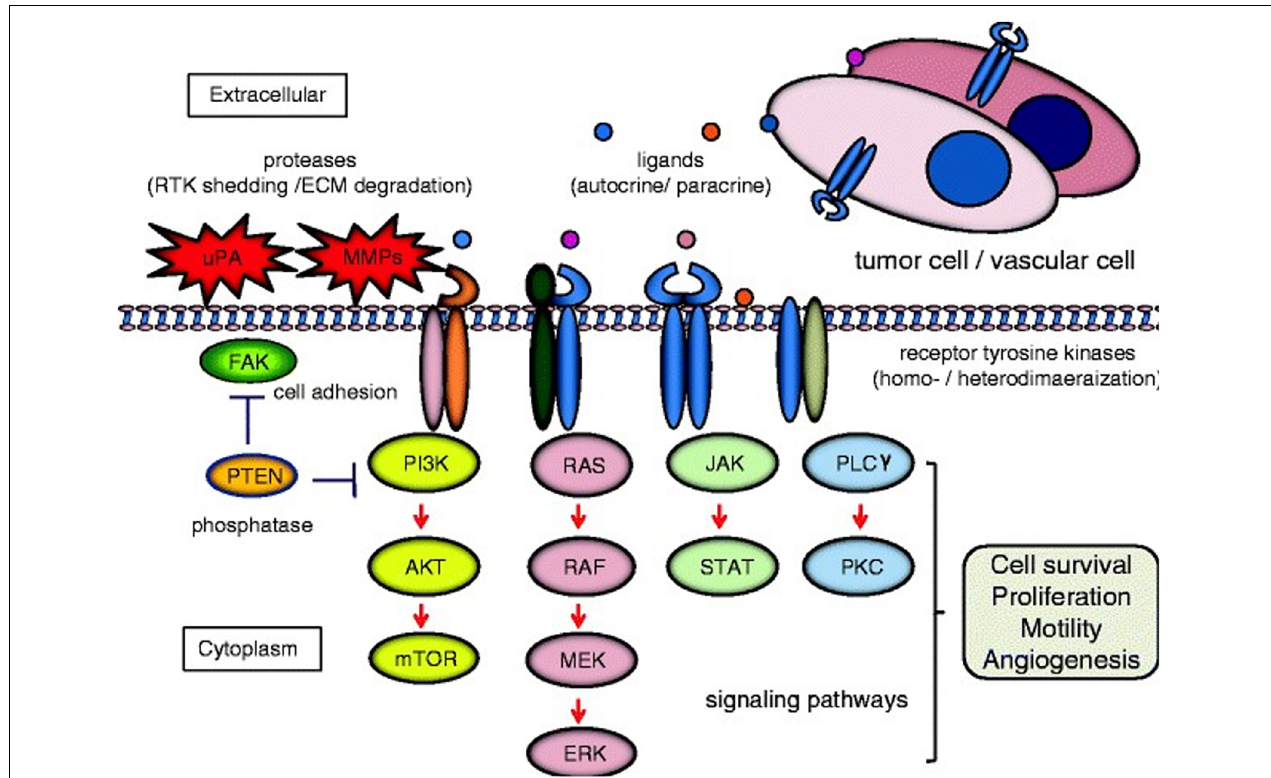
FIGURE 2 | Cell signaling pathways induced by receptor tyrosine kinases (RTK). Homo-/heterodimerization of RTKs are caused by their ligands in autocrine or paracrine fashion. The dimerized receptors can initiate signal transduction cascades involved in cell survival, proliferation, motility, and angiogenesis e.g., phosphatidylinositol 3-kinase (PI3K)/AKT/mTOR; RAS/RAF/mitogen-activated protein kinase (MEK)/extracellular signal-regulated kinase (ERK); Janus kinase (JAK)/signal transducer and activator of transcription (STAT); and phospholipase C γ (PLC) γ /protein kinase C (PKC). Examples of cross-talk between RTK signaling and proteins associated with cell invasion [e.g., urokinase-type plasminogen activator (uPA), matrix metalloproteinase (MMP)s, focal adhesion kinase (FAK), and phosphatase and tensin homolog deleted from chromosome 10 (PTEN)] are demonstrated. Red arrows and blue bars indicate activation and suppression, respectively extracellular matrix (ECM). Reprinted from Ghosh et al.